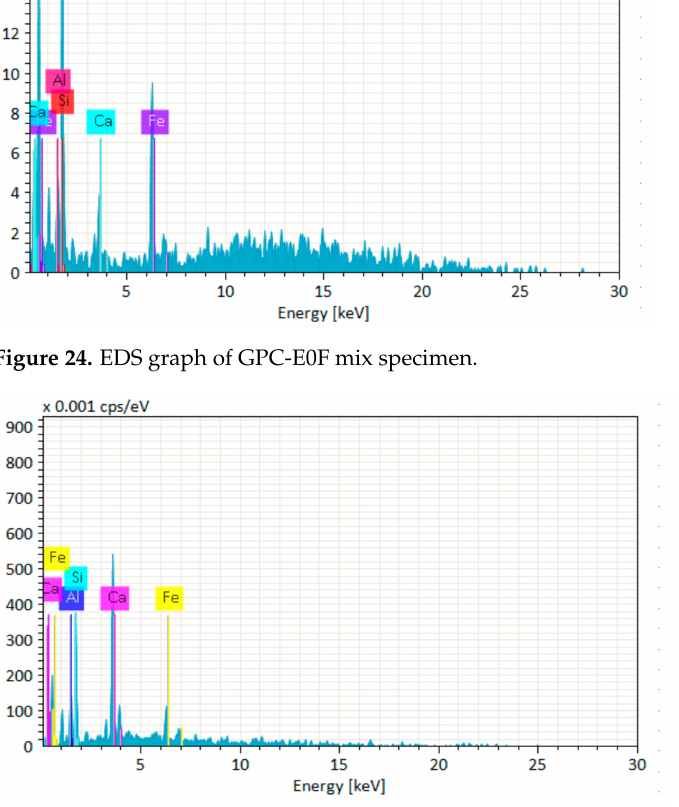
Figure 25. EDS graph of OPC-0F mix